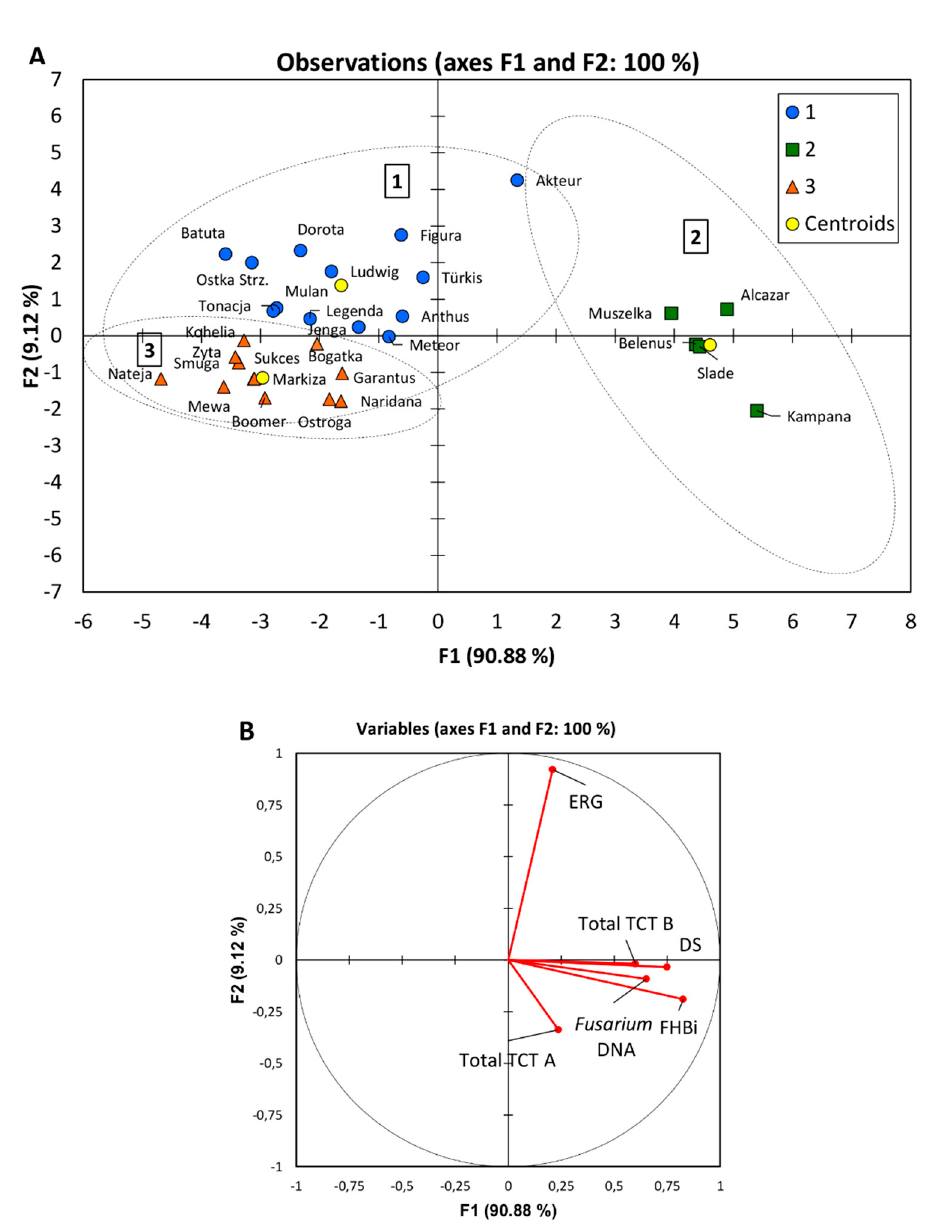
Figure 3. Discriminant analysis of 30 cultivars grown in organic field for Fusarium head blight index (FHBi), dead seeds proportion (DS), ergosterol (ERG), type A (Total TCT A) and type B (Total TCT B) trichothecenes content, and concentration of DNA of five Fusarium species in grain ( Fusarium DNA): ( A ) Observations on the factor axes with marked groups 1–3; ( B ) Correlation circle. Table 9. Average values for groups shown in Figure 3A.